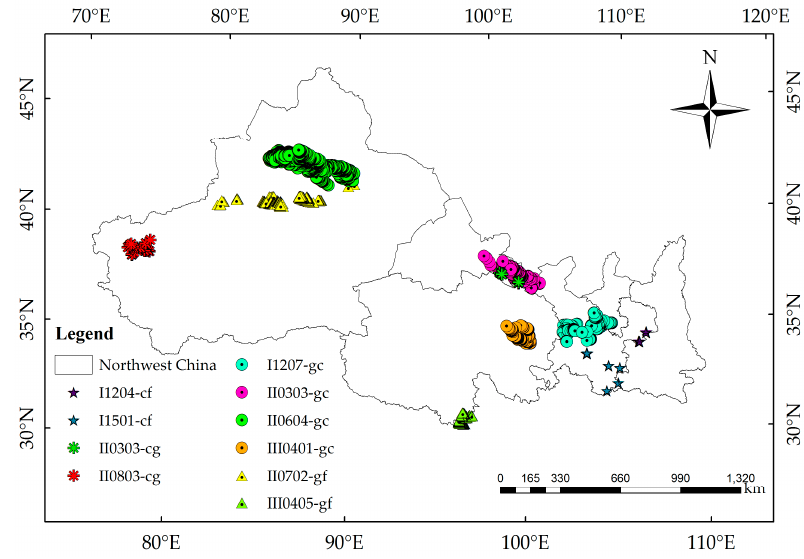
Figure 3. Spatial distribution of the selected site in subecoregions in Northwest China.